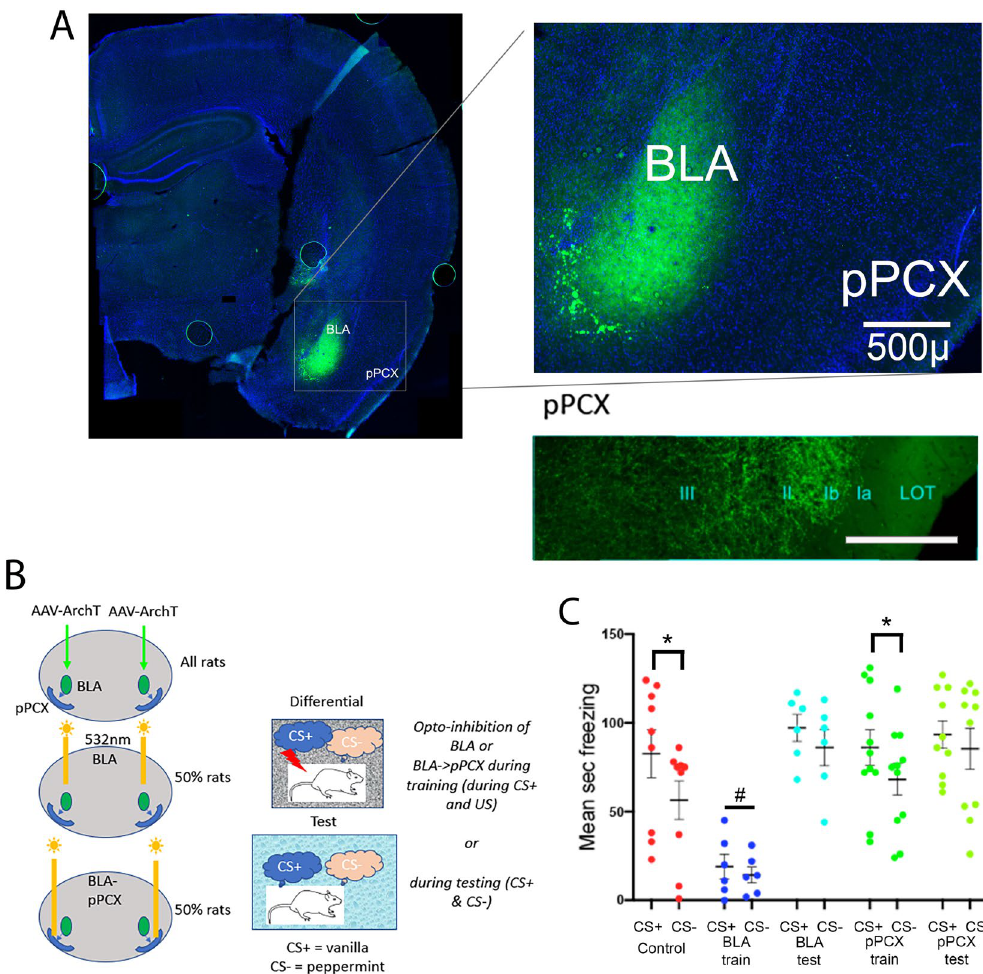
Figure 6. ( A ) Example of AAV5-CaMKIIa-eArchT3.0-eYFP infusion into the BLA. Animal was perfused 2 months after the experiment was completed, thus some viral over-expression is observed. Optical fiber track is not in this section. Lower right panel shows YFP labels BLA fibers within pPCX. Scale in inset = 100µ. ( B ) Experimental design. AAV5-CaMKIIa-eArchT3.0-eYFP, or control virus, was infused bilaterally in the BLA. Optical fibers were implanted bilaterally targeting either the BLA or BLA fibers within the pPCX to allow suppression of activity within the BLA or selectively BLA projections to the pPCX during odor threat conditioning or testing. ( C ) Odor-evoked freezing to the CS+ and CS− in each group. Viral/light Controls froze significantly more to the CS+ than the CS−, as did animals that had BLA projections to the pPCX suppressed during training (asterisks signify significant difference between CS+ and CS−, p < 0.05). Suppression of the BLA during training blocked threat conditioning (# signifies significant difference from all other groups, p < 0.05). Suppression of the BLA, or selectively of the BLA projection to the pPCX during testing, however, did not impair expression of CS+ evoked freezing, but did enhance generalization to the CS−. There were no differences in odor-evoked freezing between the CS+ and CS− in these